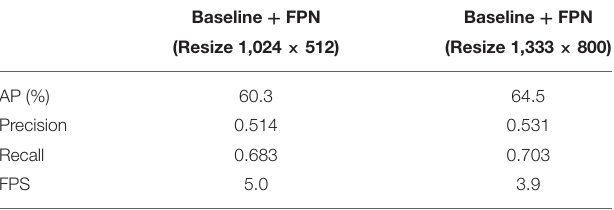
TABLE 2 | Effects of changing resize parameters of the detection system.